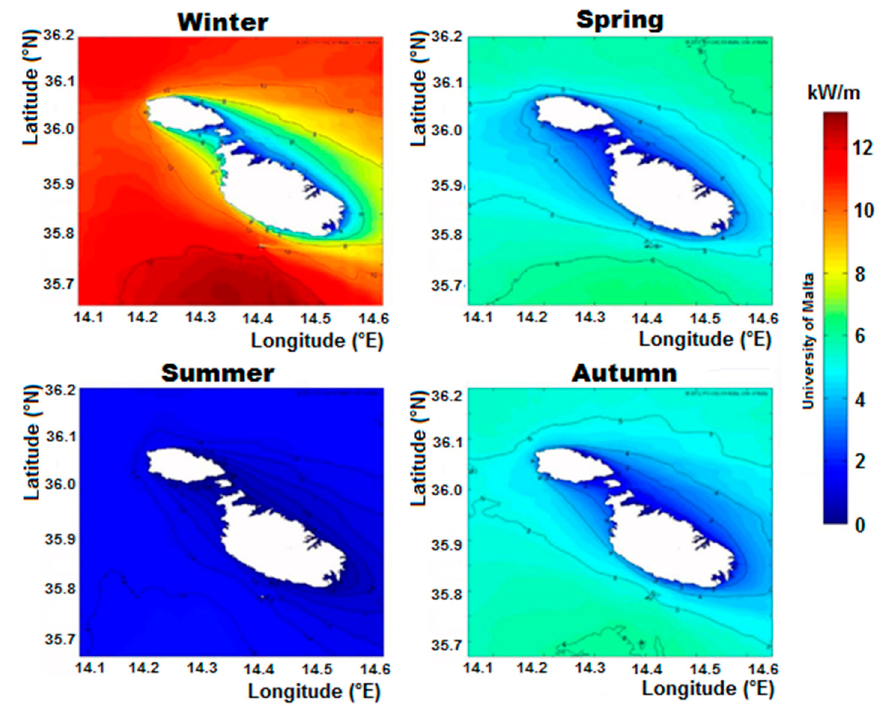
Figure 10. Seasonal wave power along the Maltese islands for the SWAN model domain [29].